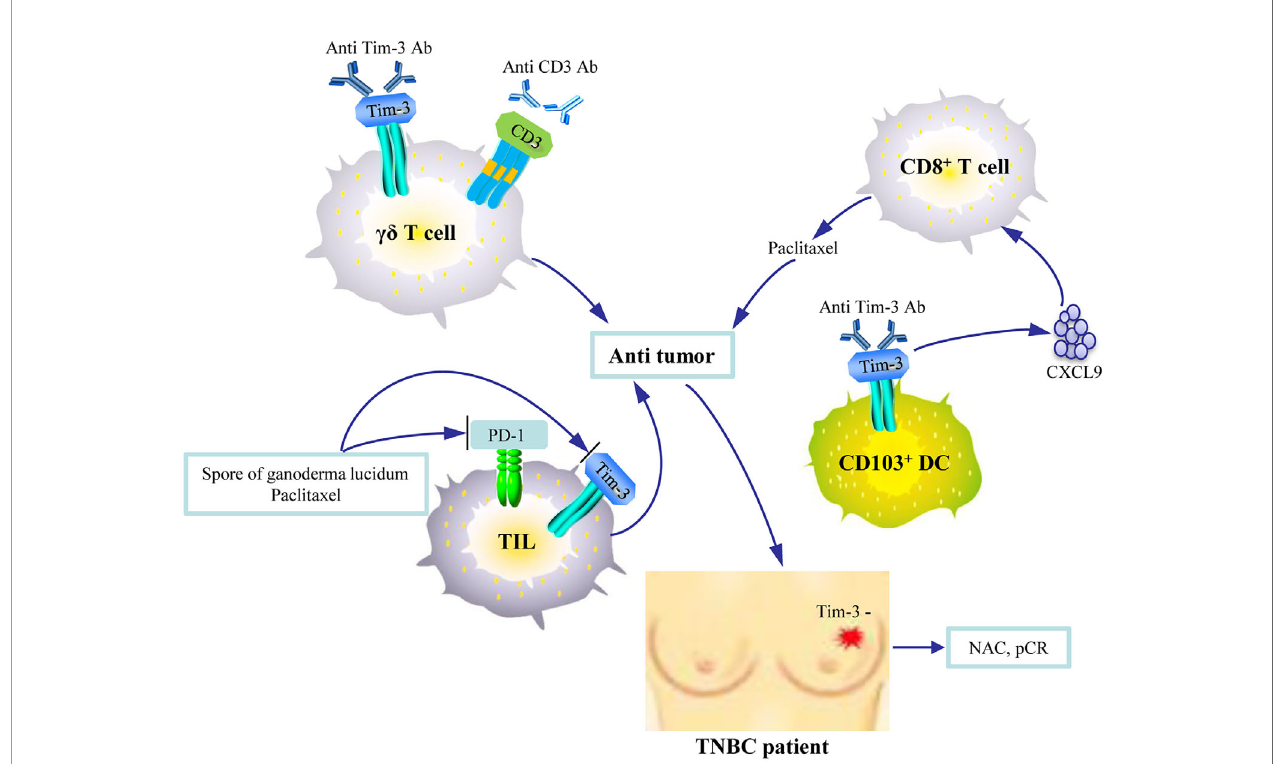
FIGURE 3 | An illustration of the therapeutic signi fi cance of Tim-3 blockade in breast cancer. The combined use of Tim-3 inhibitors and anti-CD3 agents enhances the anti-tumor activity of the adoptively transfused gd T cells. Anti-Tim-3 antibody promotes CXCL9 expression by CD103 + DCs, which enhances the function of CD8 + T cells and improves paclitaxel ’ s therapeutic activity. The combination of paclitaxel and Ganoderma lucidum spores enhances tumor control by allowing the recovery of the exhausted tumor in fi ltrating lymphocytes (TILs) by inhibiting Tim-3. Tim-3-negativity on TILs is associated with pathologic complete response (pCR) after neoadjuvant chemotherapy (NAC) in patients with triple-negative breast cancer